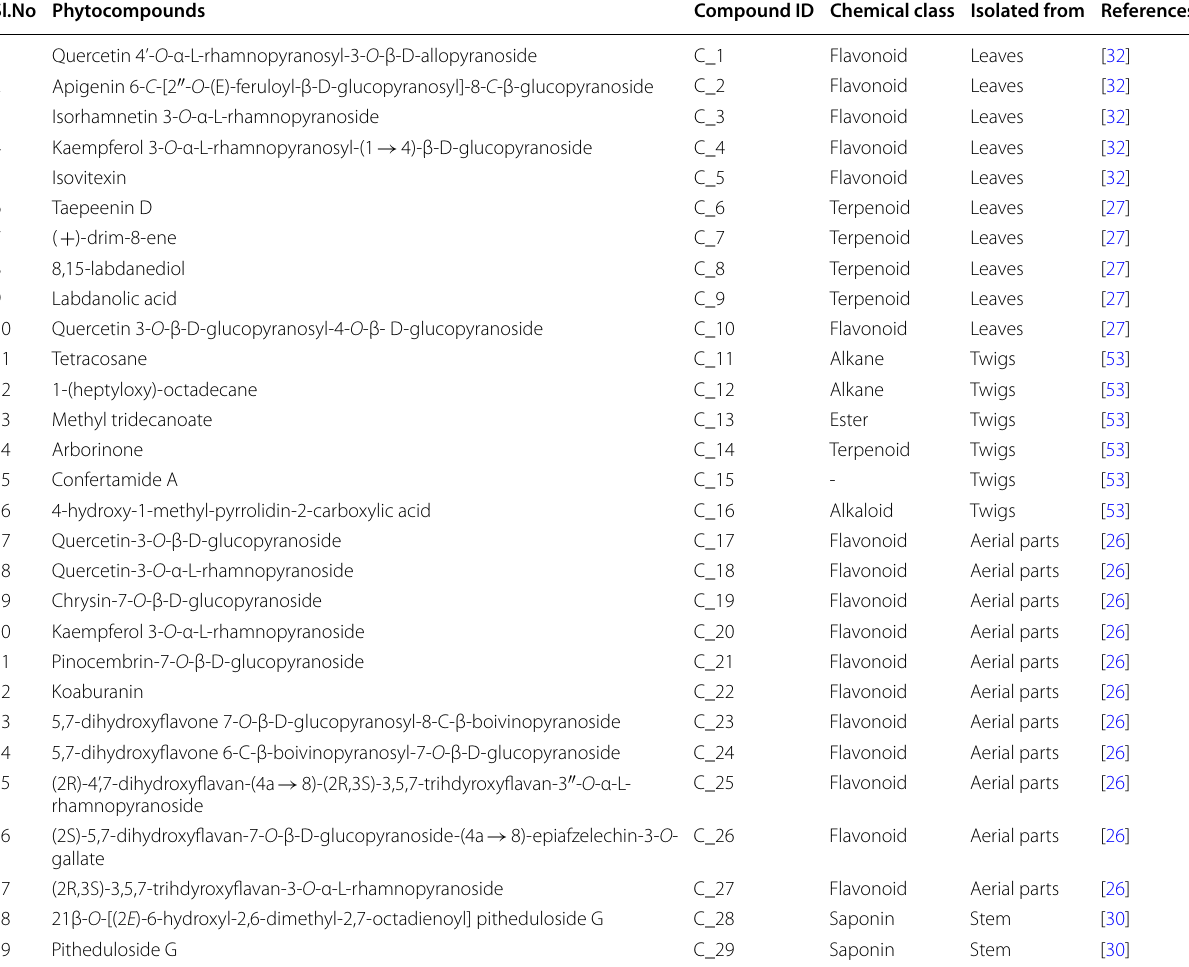
Table 1 List of phytocompounds isolated from A. pennata Sl.No Phytocompounds Compound ID Chemical class Isolated from